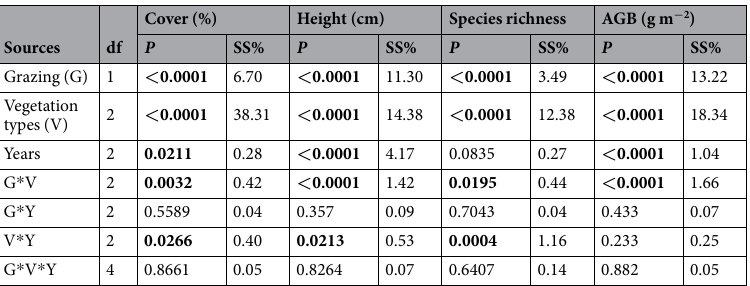
Table 1. Results of three-way ANOVAs using grazing treatment, vegetation types and years as fixed factors. df, P, SS% were the abbreviations of degree of freedom, P values and percentage of sum square explained by sources,